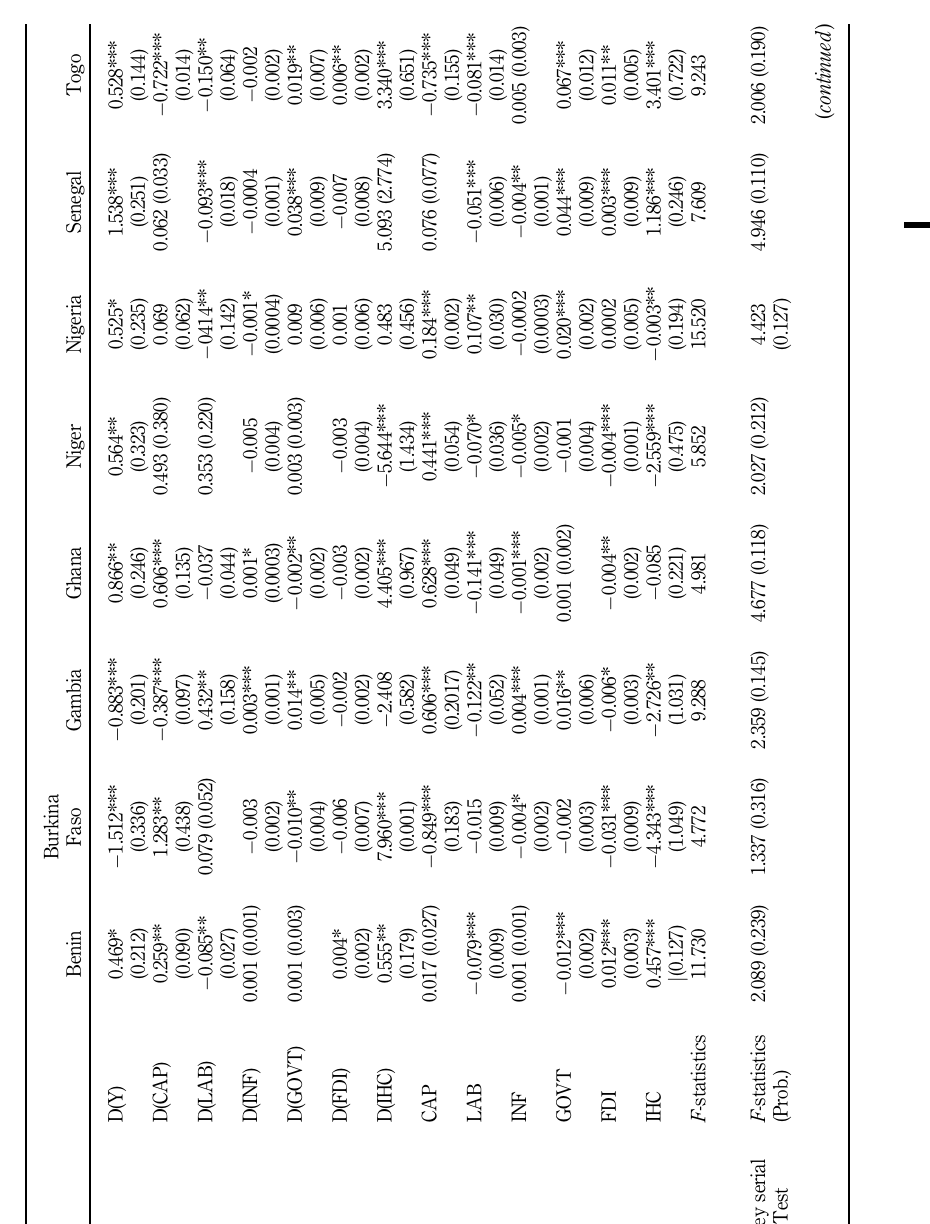
Table 4. Models with index